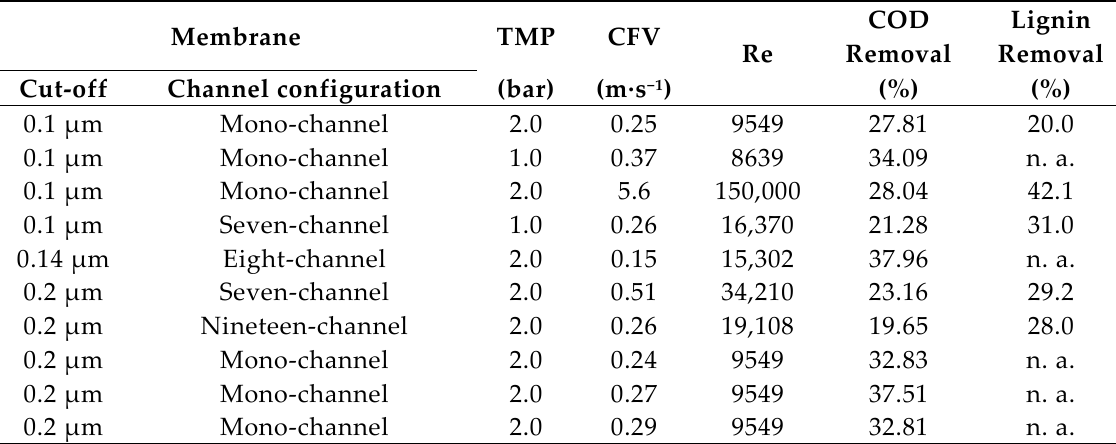
Table 4. Selected performance data for 0.1, 0.14 and 0.2 µm ceramic microfiltration membranes (n. a. = not